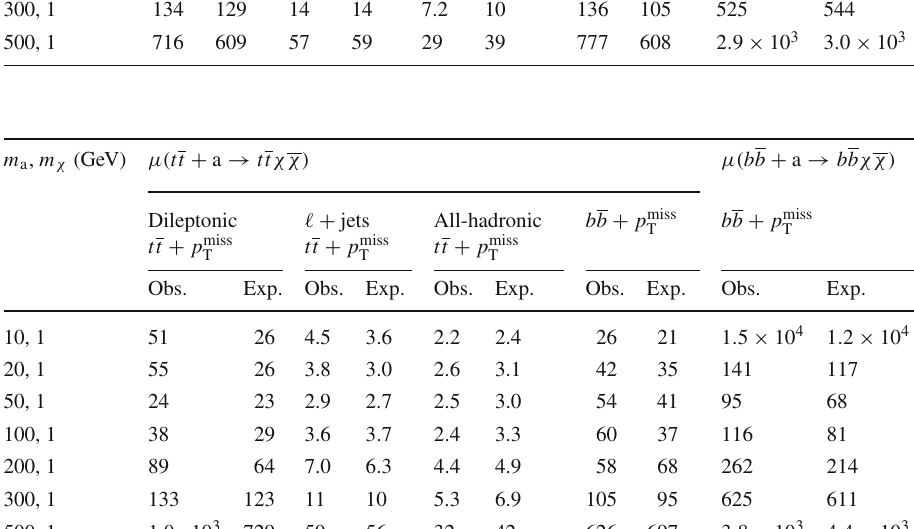
Table 5 Observed and expected 95% CL upper limits on the ratios ( μ ) of the observed tt + χχ and bb + χχ cross sections to the simplified model expectations. The limits correspond to separate fits to the bb + p miss and individual T tt + p miss search channels. DM T mediators with scalar couplings of g q = g χ = 1 are assumed